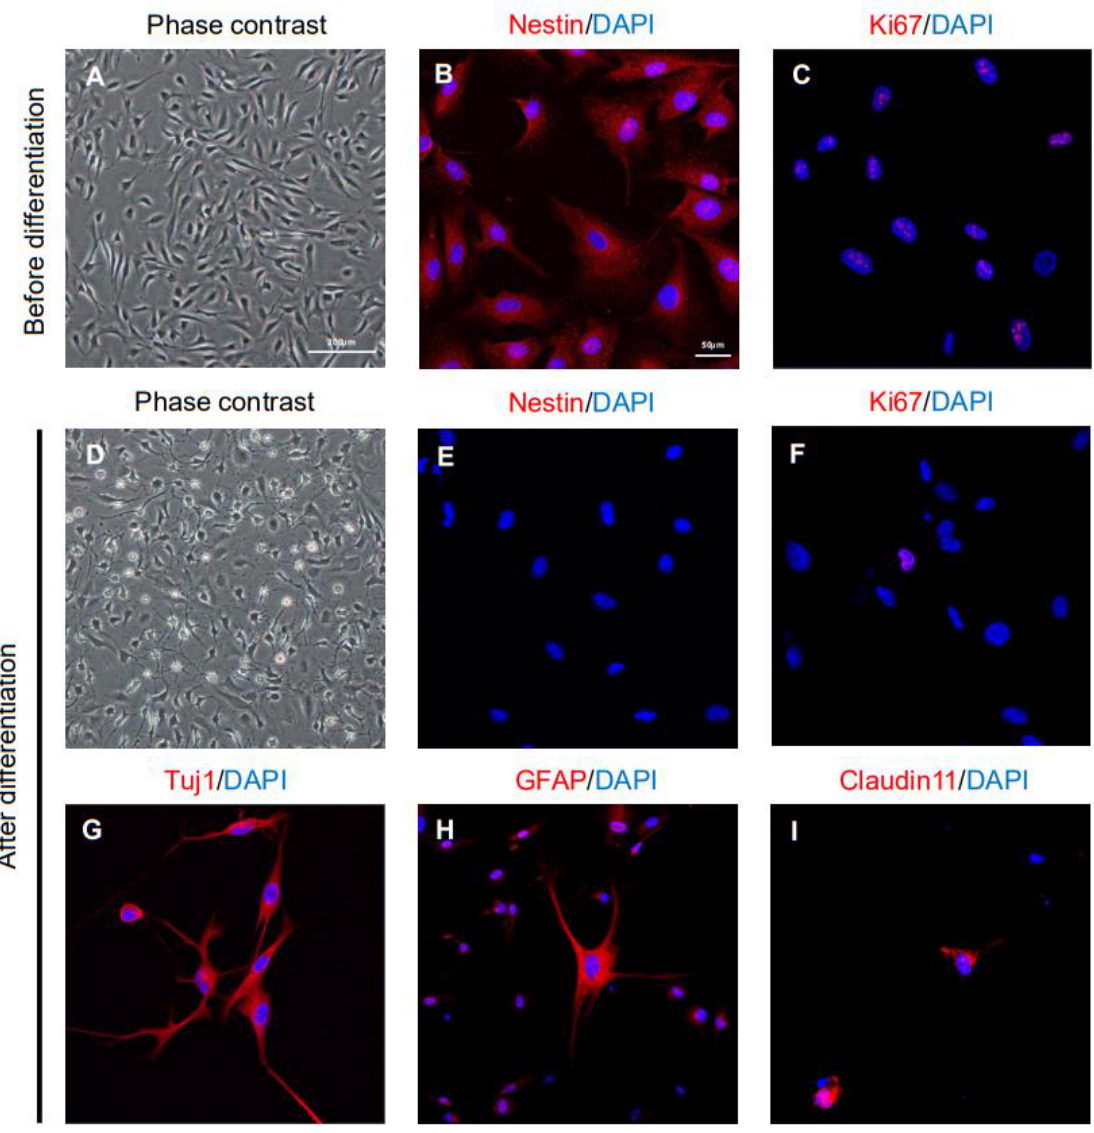
Figure 1. Characteristics of ahMNCs isolated from patients with hemorrhagic stroke. ( A ) ahMNCs were shown to be homogeneously bipolar and in the proliferation condition (before differentiation) at in vitro passage 6 (P6). ( B , C ) ahMNCs at P6 expressed the NSC marker, Nestin ( B ) and proliferation marker, Ki67 ( C ). ( D ) When P6 ahMNCs were subcultured under differentiation conditions (after differentiation), they demonstrated a range of morphological changes associated with differentiated neural cells. ( E, F ) The expression of Nestin ( E ) and Ki67 ( F ) decreased after differentiation. ( G – I ) Expression of differentiated neural cell markers such as Tuj1 ( G , for neuron), GFAP ( H , for astrocyte), and Claudin11 ( I , for oligodendrocyte) was observed after differentiation. The scale bars = 200 and 50 µ m in the phase-contrast and immunofluorescence images,